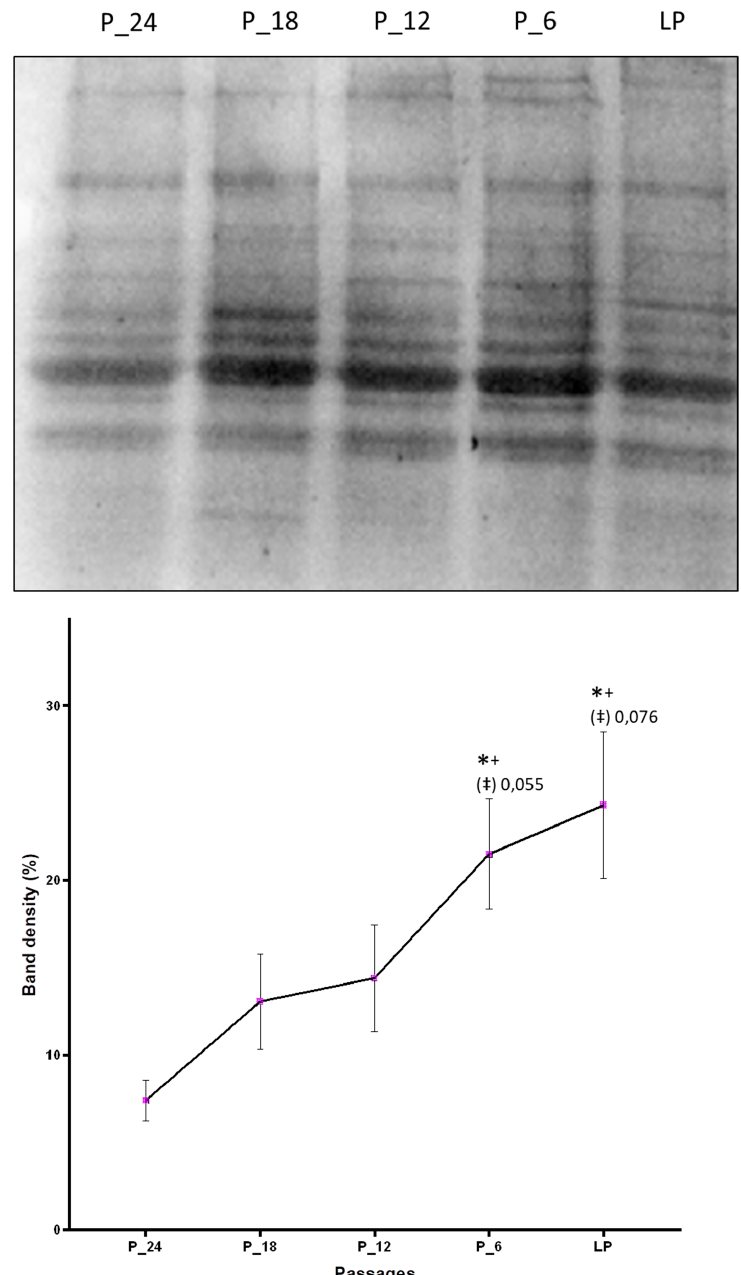
Figure 3. Changes of the amount of HNE-modified proteins due to in vitro aging assessed by Western blot analysis applying anti-HNE-his monoclonal antibodies. The band intensities were quantified by densitometry. LP indicates last passage. Data are presented as mean ± SD of band density expressed in percentages. Statistically significant differences are marked with * as compared with P-24, with + as compared with P-18, and with ‡ as compared with P-12, for p < 0.05, as analyzed by Student’s two-tailed t-test for independent samples ( n = 4).